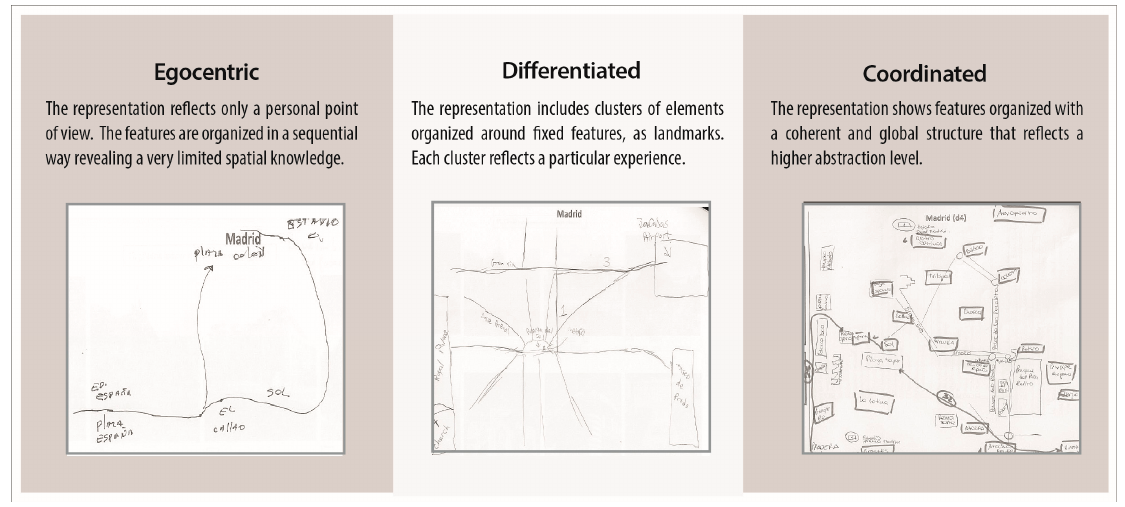
Figure 1. The three reference systems of cognitive maps, as defined by Moore [33] and identified in the sketches drawn by tourists of Madrid.